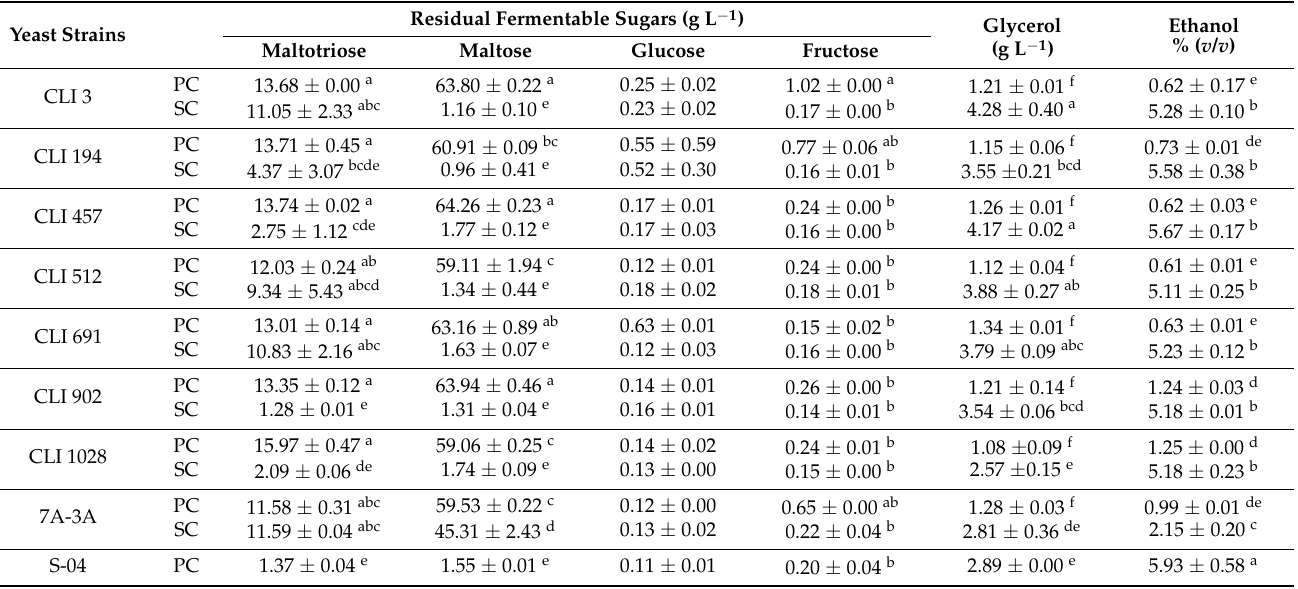
Table 3. Residual sugars, glycerol, and alcohol content in beer elaborated from pure and sequential fermentations analysed by